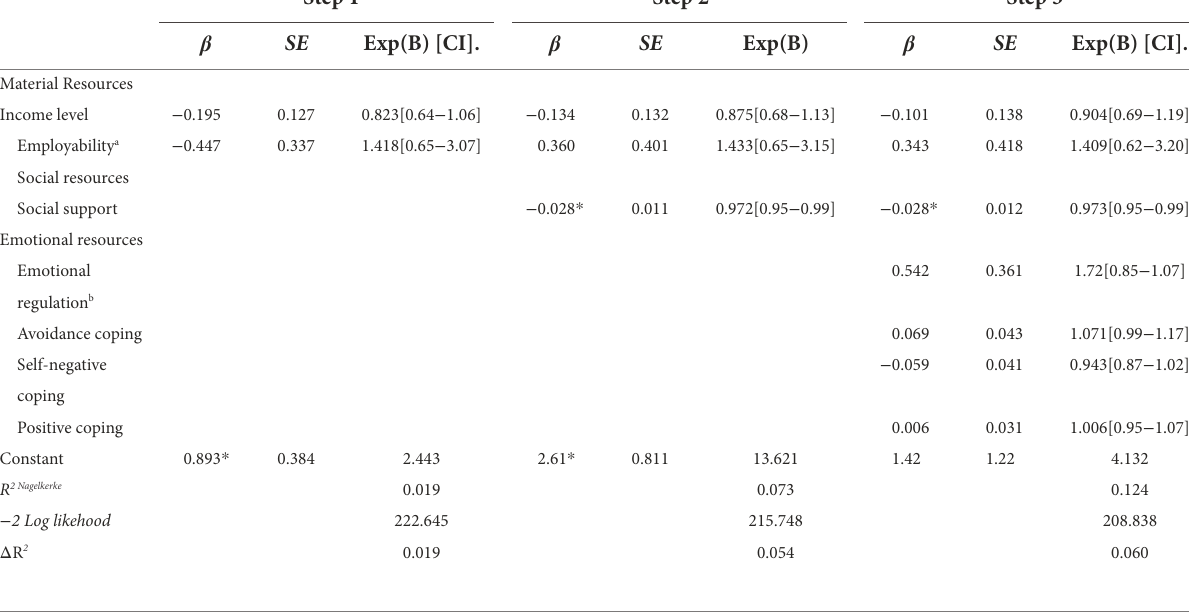
TABLE 3 Hierarchical binomial logistic